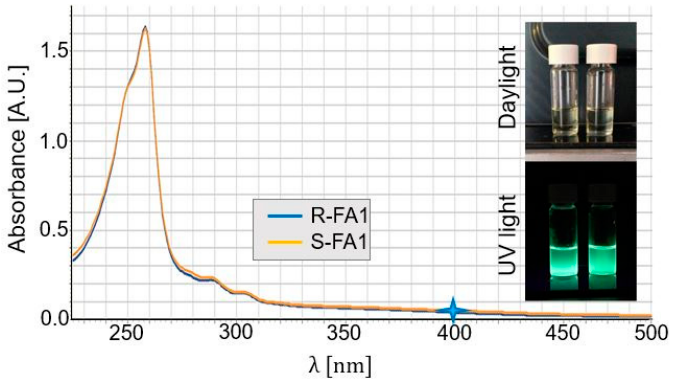
Figure 2. Absorbance spectra of the pure enantiomeric compounds R -FA1 and S -FA1. Insets: photos of the DMF solutions of R -FA1 and S -FA1 in daylight ( top ) and under UV light excitation at 365 nm ( bottom ).